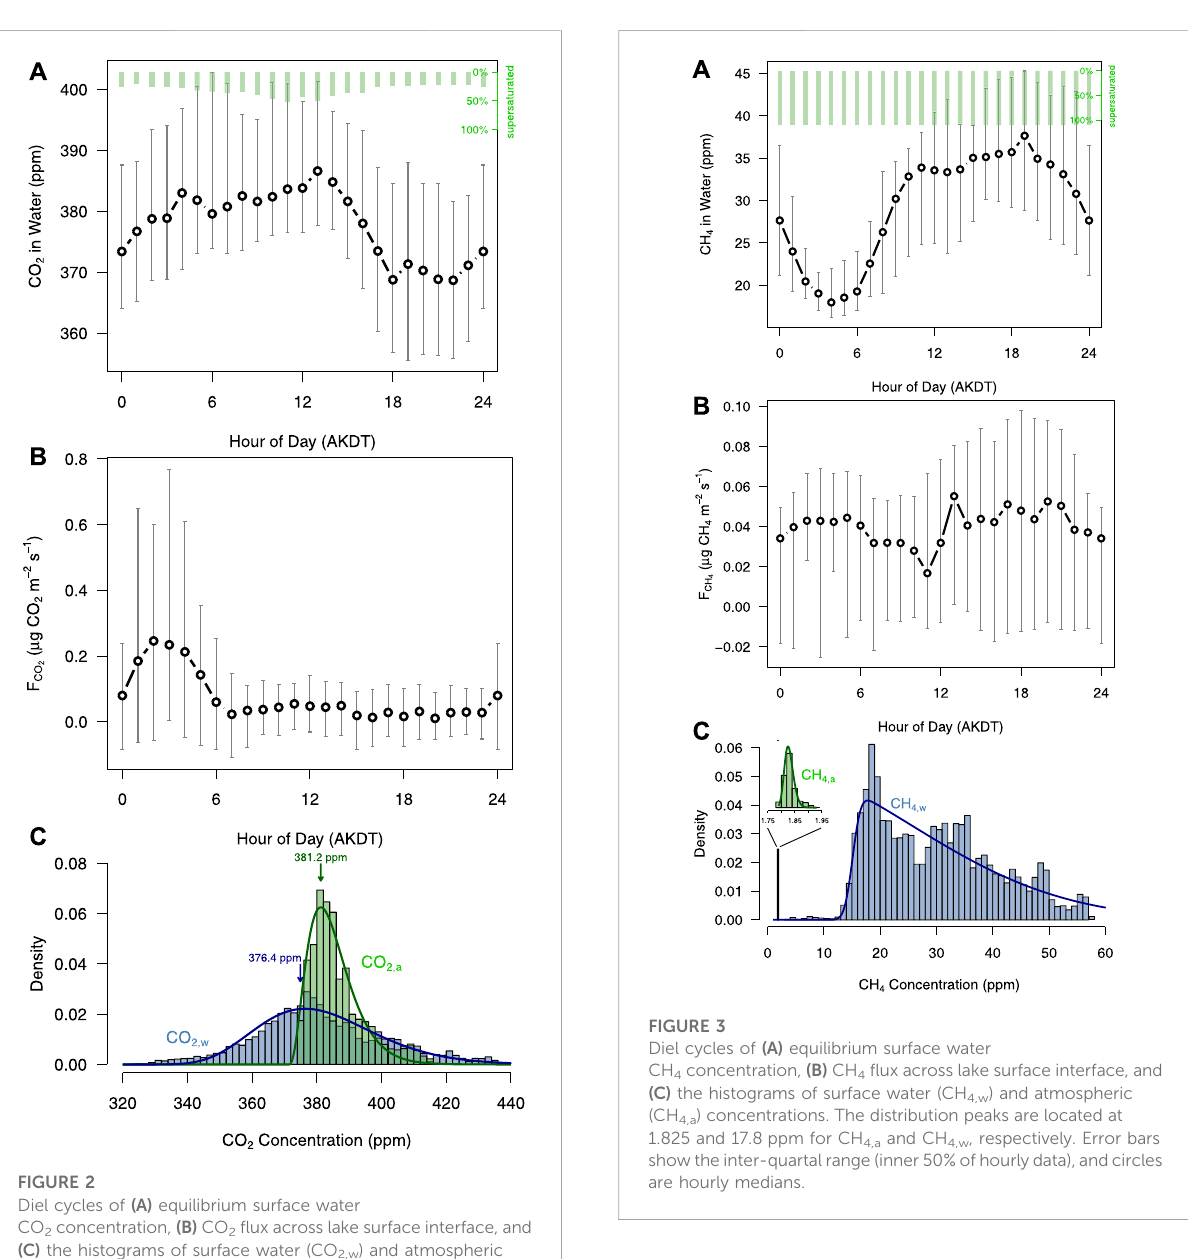
FIGURE 2 Diel cycles of (A) equilibrium surface water CO 2 concentration, (B) CO 2 fl ux across lake surface interface, and (C) the histograms of surface water (CO 2,w ) and atmospheric (CO 2,a ) concentrations. Arrows with values show the location of themaximum of the respective distribution. Error bars show the inter-quartal range (inner 50% of hourly data), and circles are hourly medians.